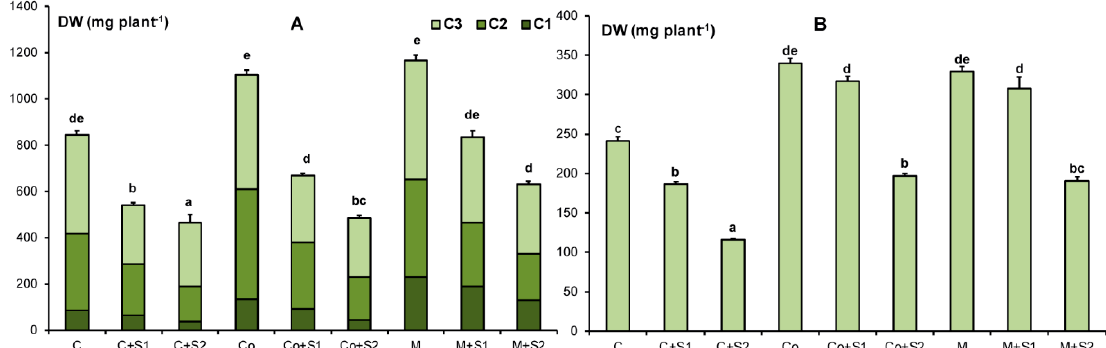
Figure 1. Growth of alfalfa in conditions of clay soil amended or not with MSWC or farmyard manure (40 mg ha − 1 ) and irrigated or not with saline water at (0, 50 mM, 100 mM NaCl). ( A ) The quantity of aboveground biomass expressed as dry matter per plant (mg plant − 1 ). ( B ) The quantity of root biomass expressed as dry matter (mg plant − 1 ). C –Control treatment. M –Soil amended with farmyard manure (40 mg ha − 1 ). Co—soil amended with compost (40 mg ha − 1 ). + S1, + S2—variants irrigated with 50 mM NaCl and 100 mM NaCl solution, respectively. C1, C2 and C3 represent three subsequent harvests of above ground biomass done at approximately 40-day intervals. The first harvest (C1) was performed 45 days after sowing. Data are means of six repeats ± SE. The di ff erent letters ( abcd ) represent a significant di ff erence between treated samples. p < 0.05 by Duncan’s multiple range test.